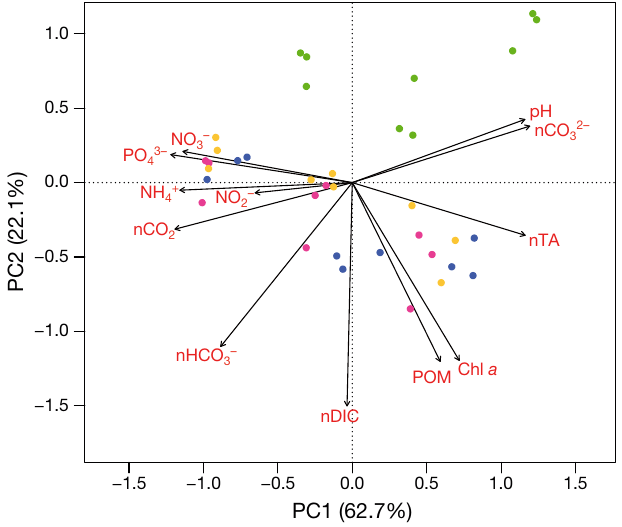
Fig. 5. Ordination diagram displaying the first (PC1) and sec- ond (PC2) axes of a principal component analysis (PCA). Loadings of the environmental variables are displayed as ar- rows, with the scheme for the variation of environmental fac- tors in each area depending on the scores of the first 2 princi- pal components. nTA: normalized total alkalinity; nDIC: normalized dissolved inorganic carbon; nHCO 3− : normalized bicarbonate, nCO 32− : normalized carbonate; nCO 2 : normal- ized carbon dioxide; NO 3− : nitrate; NH 4+ : ammonia; NO 2− : ni- trite; PO